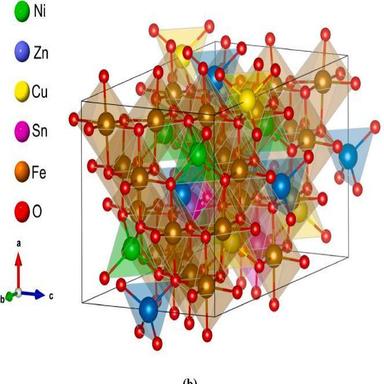
(a) XRD powder patterns and (b) unit cell structure of NCZFe2- 4xSn3xO4 NSFs.